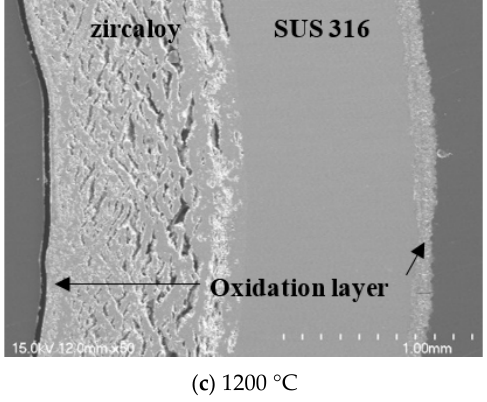
Figure 9. Scanning electron microscopy (SEM) images of cross-sections of the PST maintained at 600, 900, and 1200 °C for 1 h.